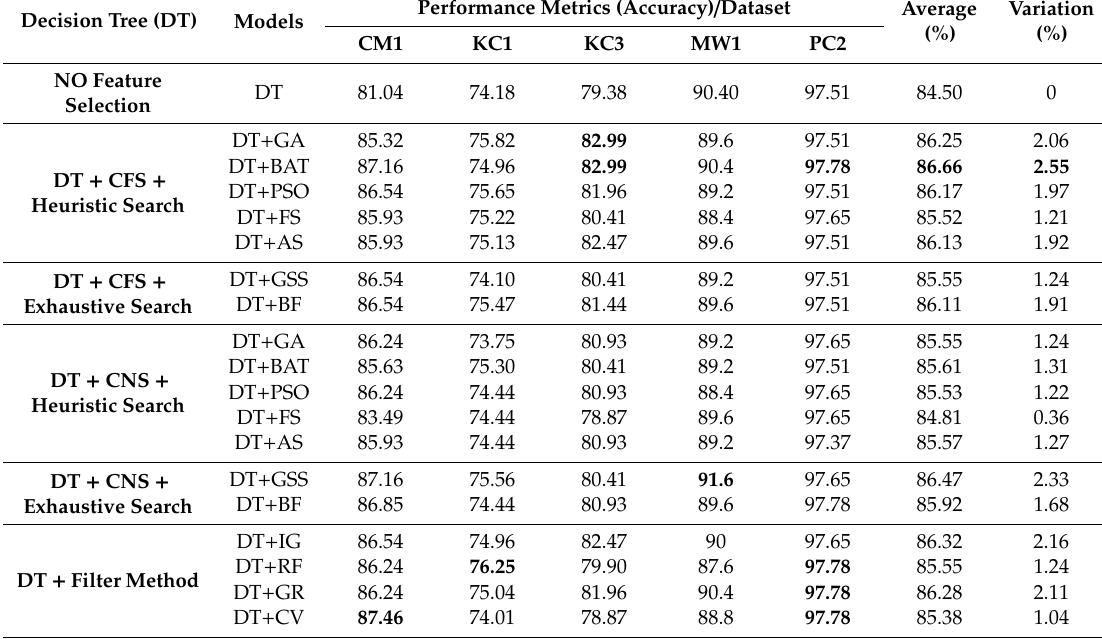
Boldface typeface indicates the highest value for each dataset.